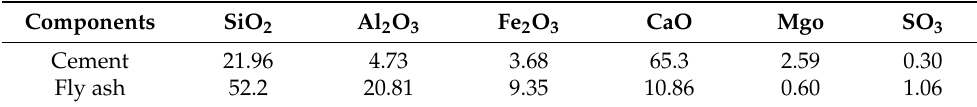
Table 1. Chemical compositions of cement and fly ash (wt%).